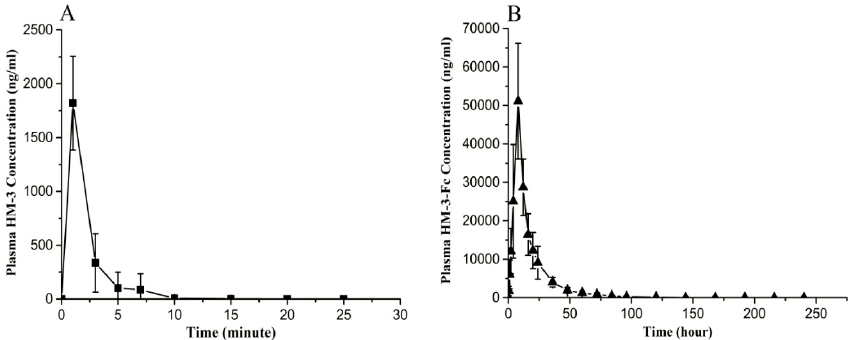
Figure 8. Serum drug concentration versus time curves of HM-3 and HM-3-Fc after subcutaneous injection in cynomolgus. ( A ) Serum drug concentration versus time curve of HM-3 after s.c. administration of 0.5 mg/kg HM-3 in cynomolgus. ( B ) Serum drug concentration versus time curve of HM-3-Fc after s.c. administration of 5.77 mg/kg HM-3-Fc in cynomolgus. Data were shown as mean ± SEM (standard error of mean). Table 3. Pharmacokinetic parameters of HM-3 and HM-3-Fc in cynomolgus a .